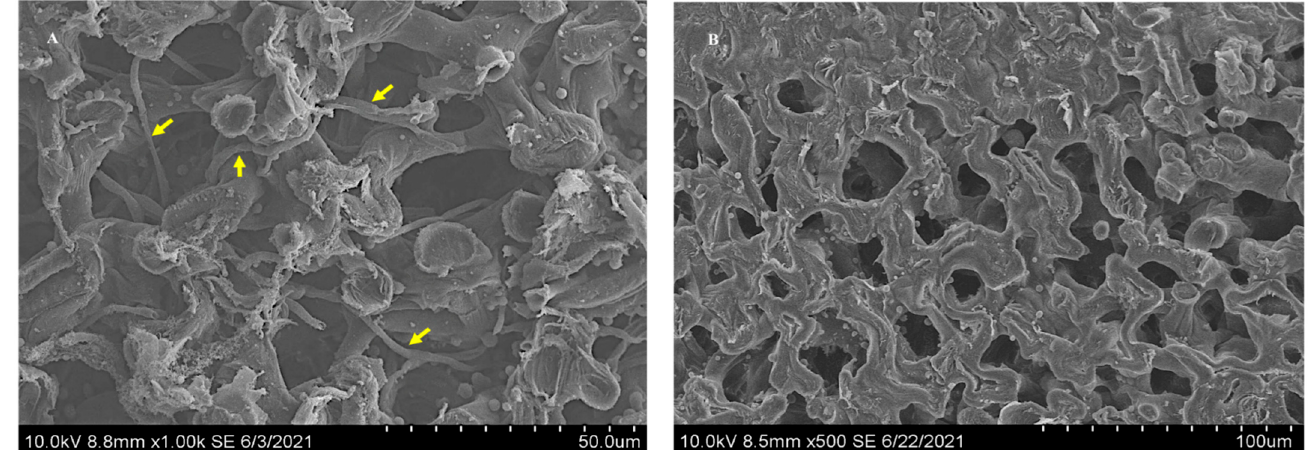
Figure 5. Scanning electron microscope images of fungal mycelia tangled around the sclereids tissue of a positive Ipomoea carnea seed indicated by the arrows ( A ), and absence of mycelia in I. carnea negative seed sclereids ( B ).